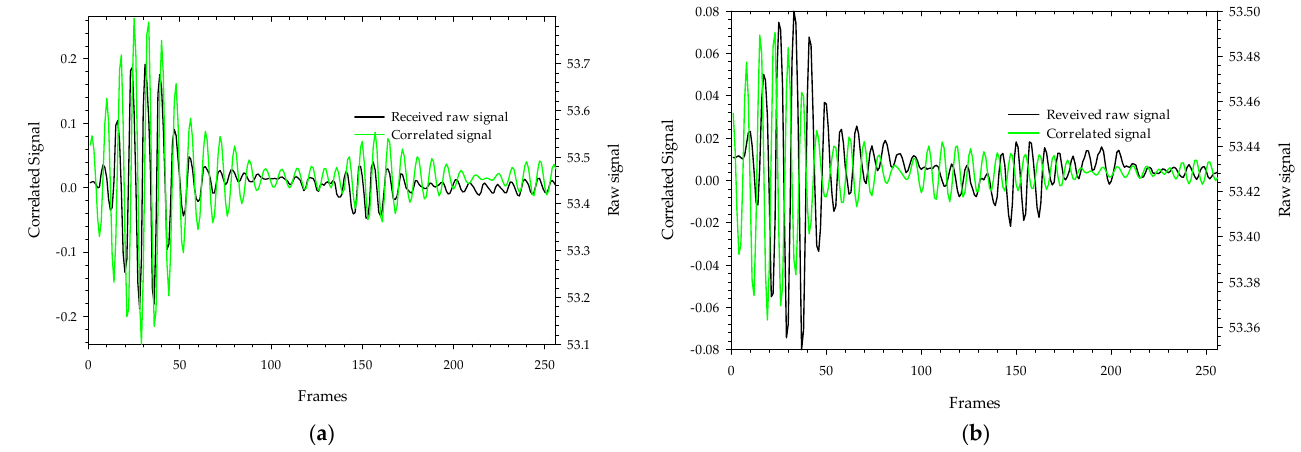
Figure 9. The received pulse shape and correlated signals from IR-UWB radar for 5.3 GHz transmis- sion:( a ) without MUT; ( b ) with MUT.